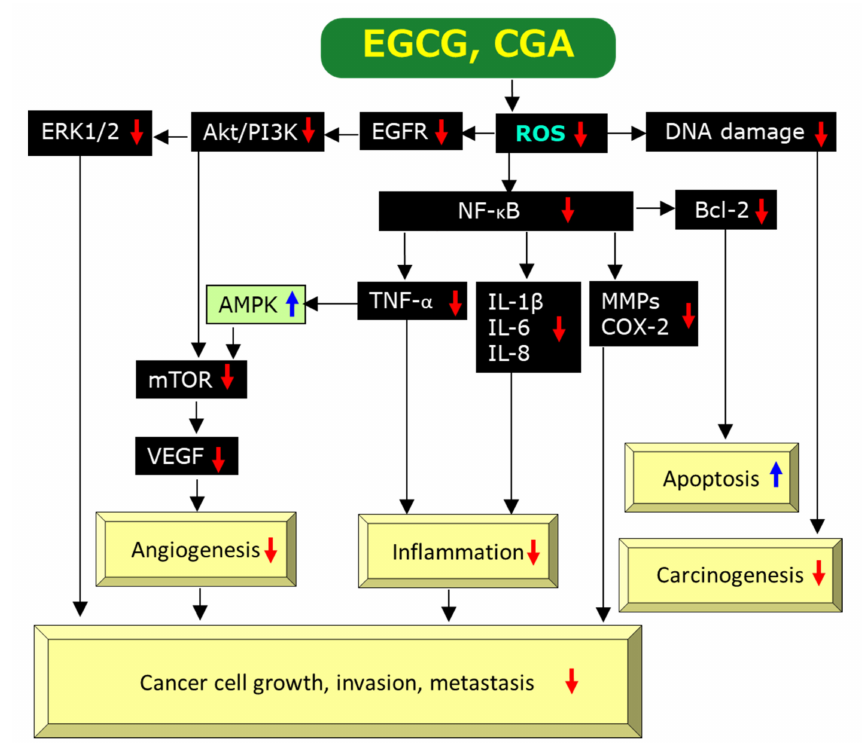
Figure 2. A possible mechanism by which EGCG and CGA exert anti-cancer e ff ects via scavenging / downregulation of ROS. Red ↓ and blue ↑ marks represent downregulation / suppression and upregulation / stimulation,